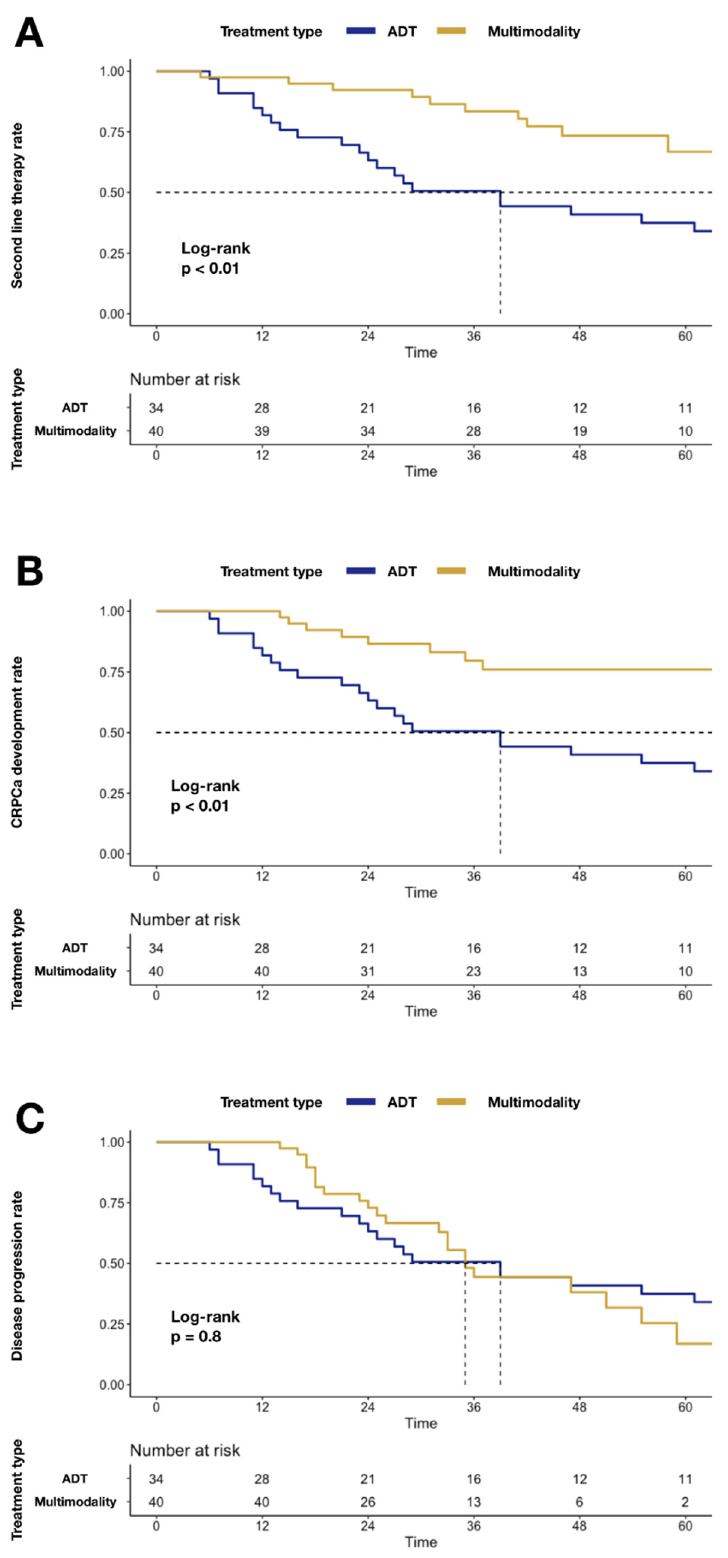
Figure 2. Kaplan–Meier plots depicting differences after stratification according to MMT vs. ADT alone: Panel ( A ) differences in second-line systemic therapy rate; Panel ( B ) differences in mCRPC rate; Panel ( C ) differences in disease progression rate. Abbreviations: cancer-specific mortality (CSM); androgen deprivation therapy (ADT); multimodality treatment (MMT); metastatic castration-resistant prostate cancer (mCRPC).